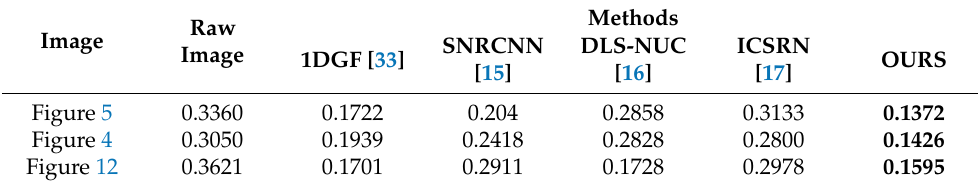
Table 2. Roughness index ( ρ ) on real noise infrared images.